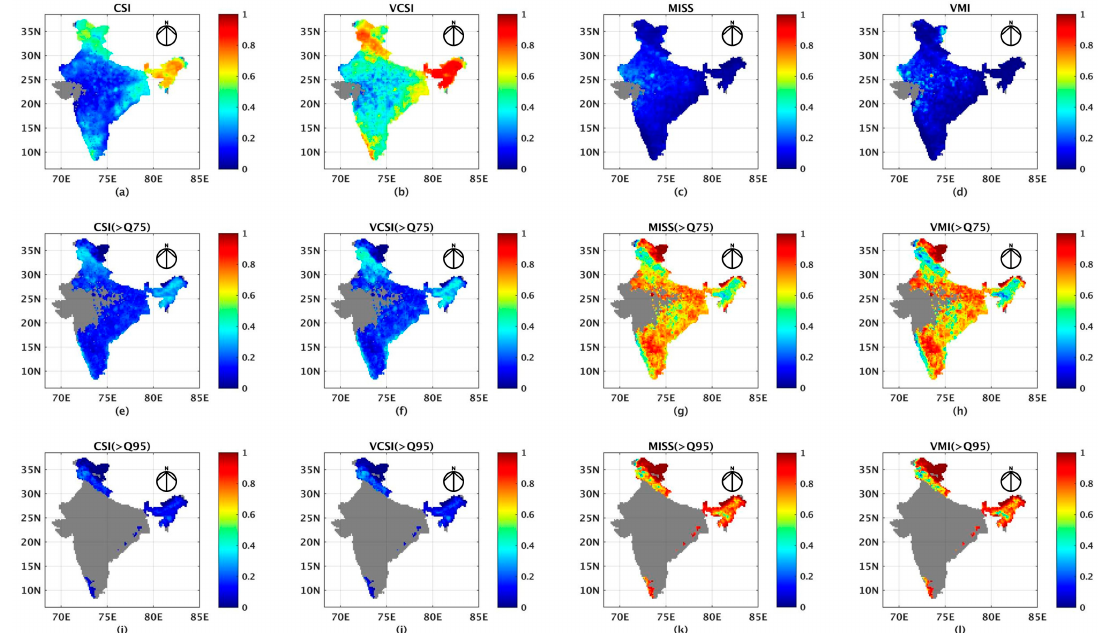
Figure 13. ( a – l ) Spatial distribution of categorical indices for the MAM months over India for daily and higher quantiles of precipitation using MSWEP and IMD daily precipitation data from 1979 to 2013 showing CSI ( a , e , i ); VCSI ( b , f , j ); MISS ( c , g , k ); and VMI ( d , h , l ).